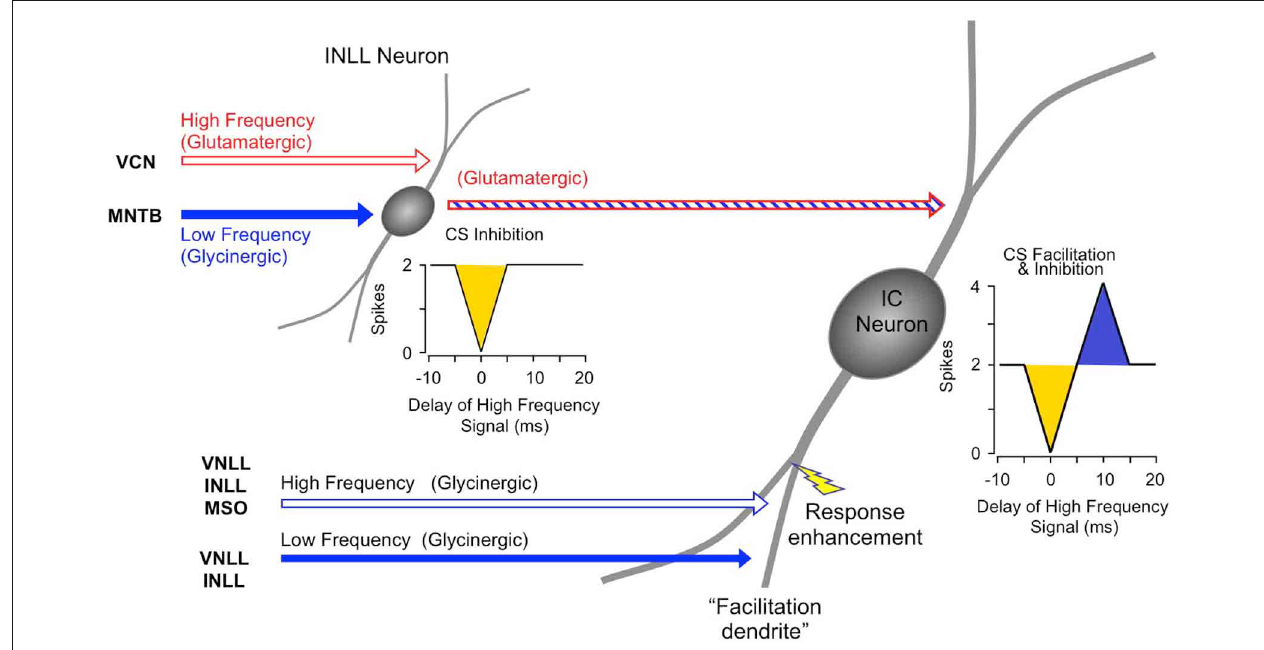
FIGURE 14 | Schematic diagram of circuitry underlying combination-sensitive facilitation and inhibition in IC neuron.